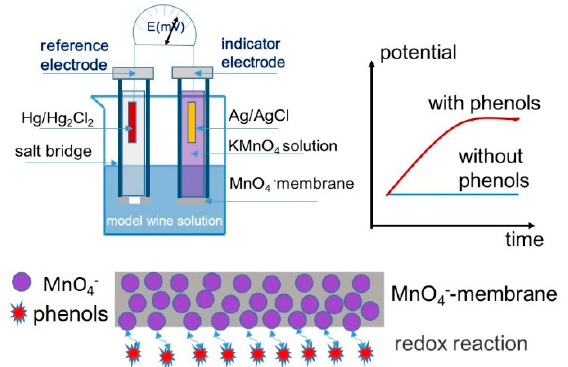
Figure 1. Potentiometric response of permanganate ions of selective electrodes (10 mM of NaCl was used as the inner filling solution and the electrode was conditioned overnight in 10 − 4 M KMnO 4 before measurements).